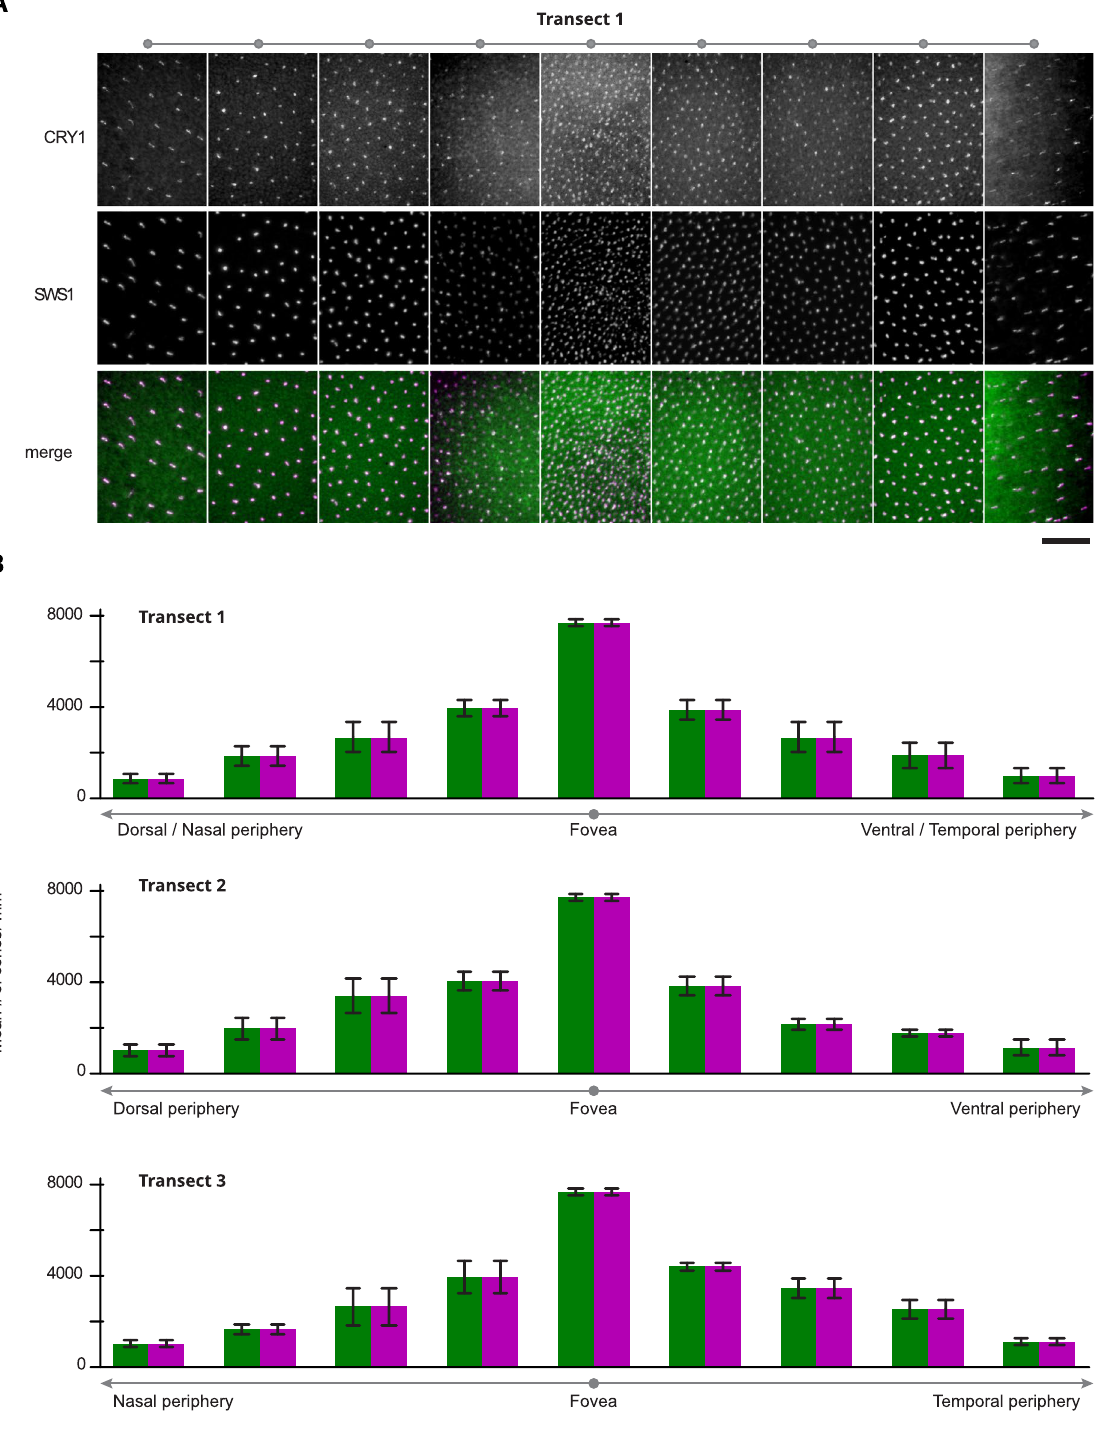
Figure 5. Quantification of the co-localisation of CRY1 and SWS1 in the zebra finch retina. ( A ) Example of sampled areas across Transect 1 of a whole-mounted retina (see Fig. 3B for position of sampling transects and counting locations). The upper row shows CRY1 positive cells, the middle row SWS1 positive cells, and the bottom row the merged images (CRY1 in green, SWS1 in purple and colocalisation is seen as white). ( B ) Mean number (± standard deviations) of immunopositive cells per mm 2 for each sampling location along the three transects. The counts are based on six retinas from four individual birds (see Table S1). Bar: 30